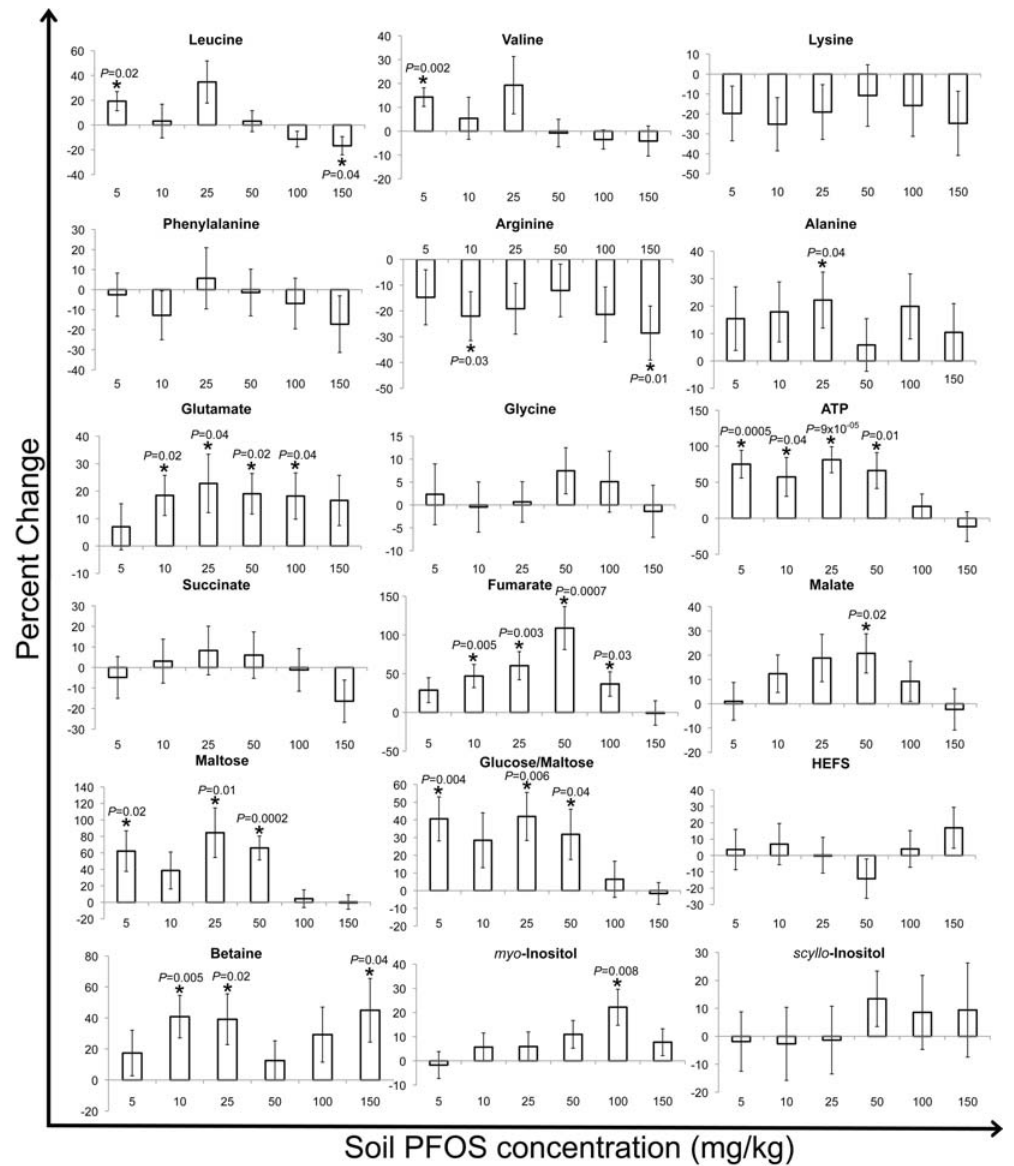
Figure 5. Percent (%) change in selected metabolites of seven-day PFOS-exposed Eisenia fetida tissue extracts compared with the control earthworms. The % changes in the intensity of metabolite resonances of exposed earthworms relative to the controls were obtained by first subtracting the buckets that pertain to the metabolites in the control earthworms from the exposed earthworms for each exposure concentration and then dividing again by the buckets in the control earthworms [31,43]. The percent changes that were significantly (at α = 0.05) different from the control (based on a t -test (two tailed, equal variances) of control vs. exposed) are labeled with an asterisk (*) and also show the corresponding p -values. The percent changes are shown with their associated standard